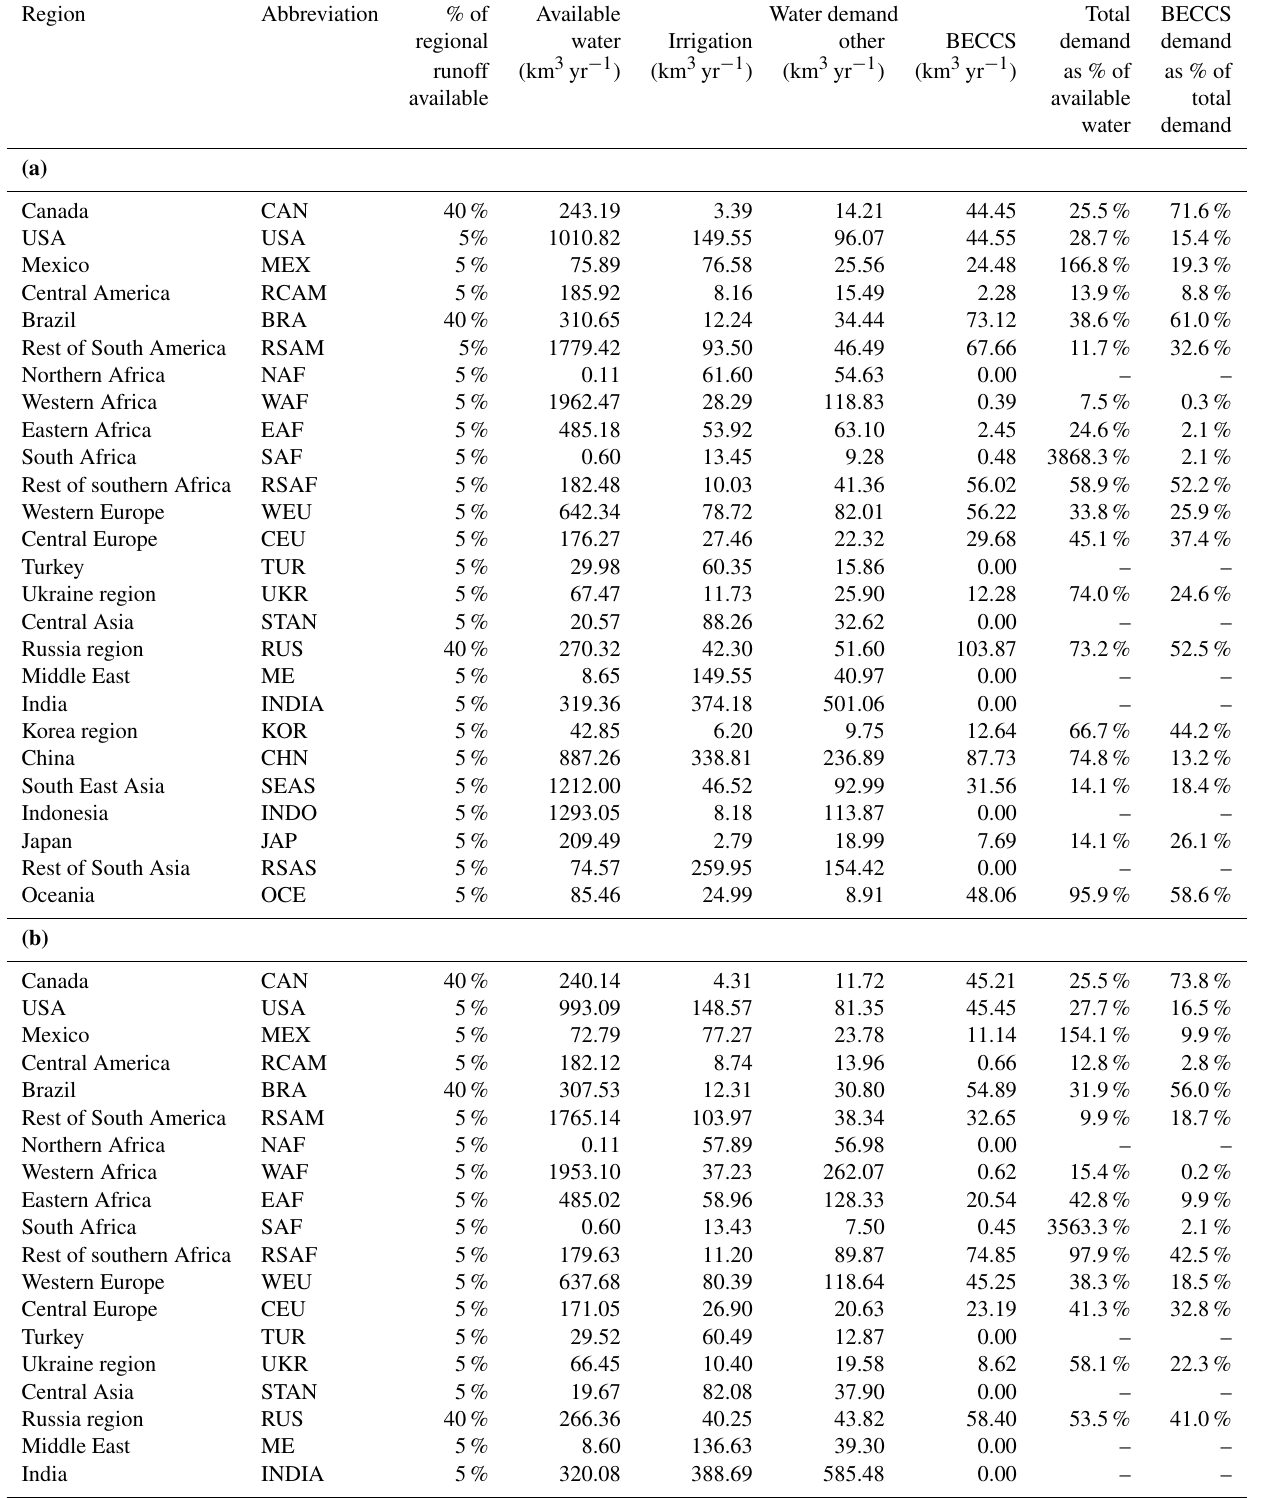
Table 4. (a) Comparison by IMAGE region of the modelled available water (km 3 yr − 1 ), the projected water withdrawals (km 3 yr − 1 ) for irrigation and for other anthropogenic activities (energy generation, industry, domestic) from the IMAGE SSP2-RCP2.6 scenario, and the additional water required for BECCS (km 3 yr − 1 and as percentages of the net available water and of the water withdrawals for irrigation and other) for the year 2060. The percentage of runoff available for human use by IMAGE region is also included. Section (b) is the same as (a) but for